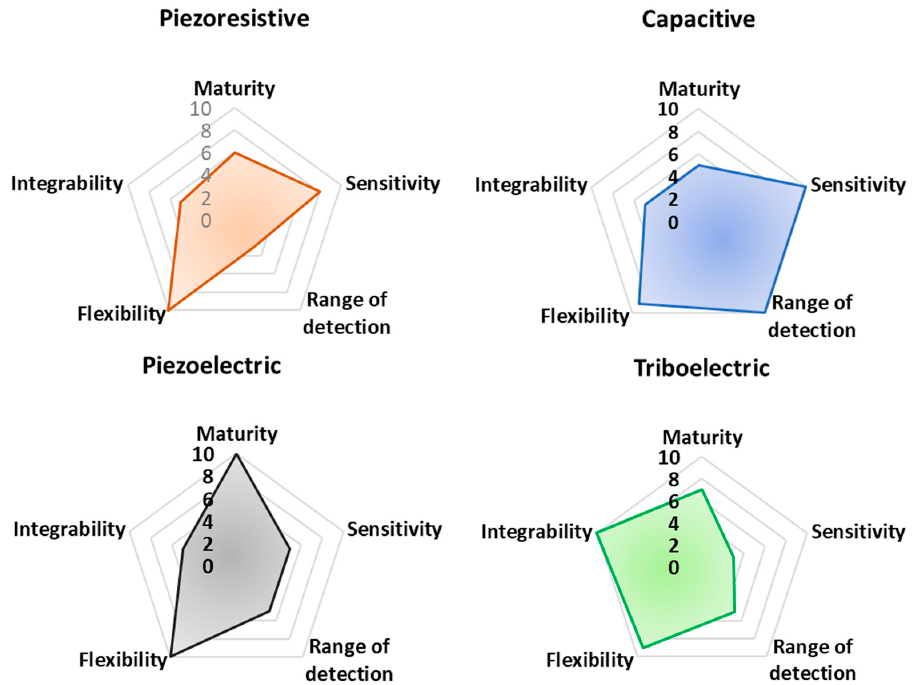
Figure 15. Radar chart showing a comparison between the analyzed sensors and devices according to their technological maturity, flexibility, ability for full integration into clothes and garments, sensitivity, and range of detection.